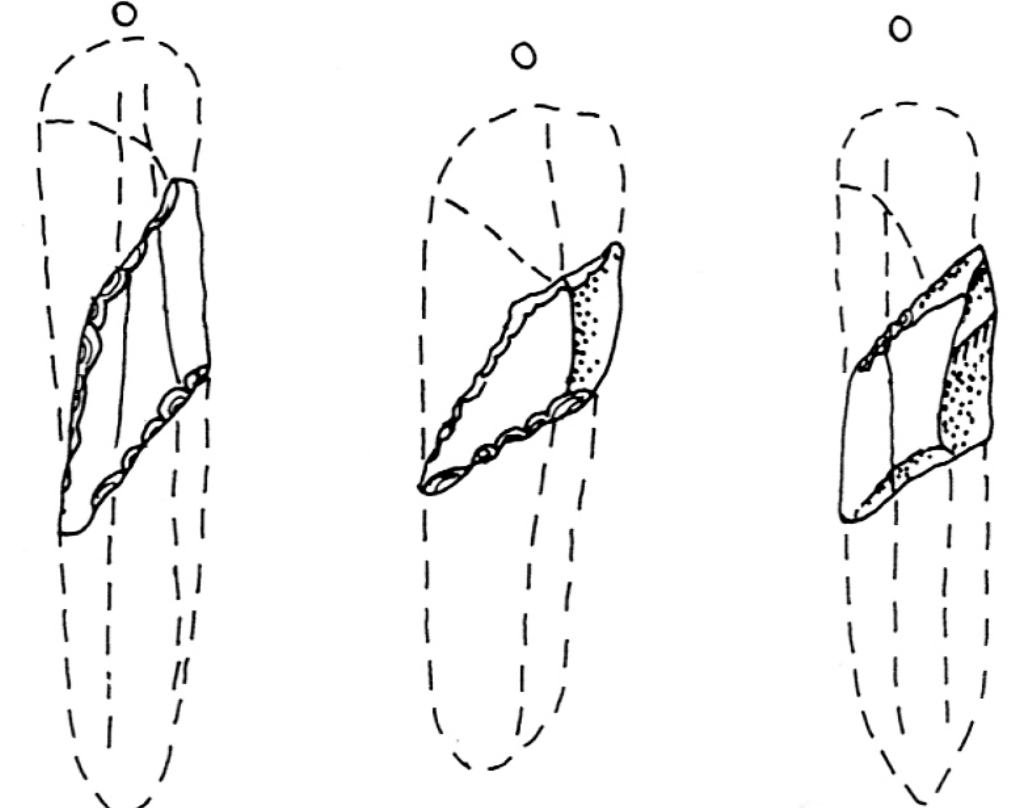
Figure 8. The production of pieces belonging to the continuum of tanged, single-edged and transverse arrowheads (courtesy of Hans Kindgren; Kindgren 2002, Fig.